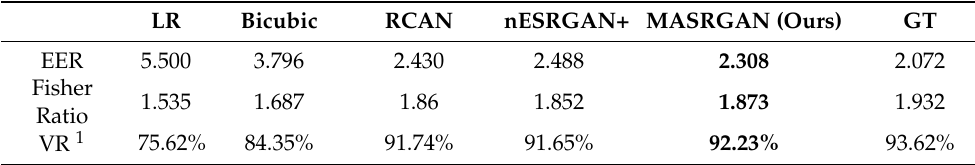
Table 3. The comparison with different resolution in terms of EER and corresponding criteria.